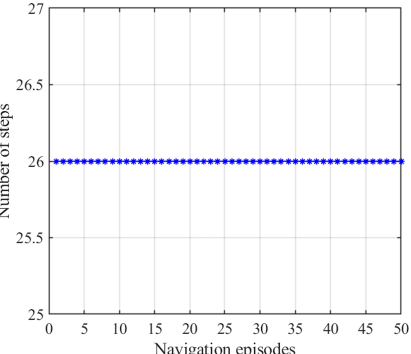
Figure 8. Number of steps with the hippocampal model alone. Blue asterisks indicate the navigation steps for each navigation episode.